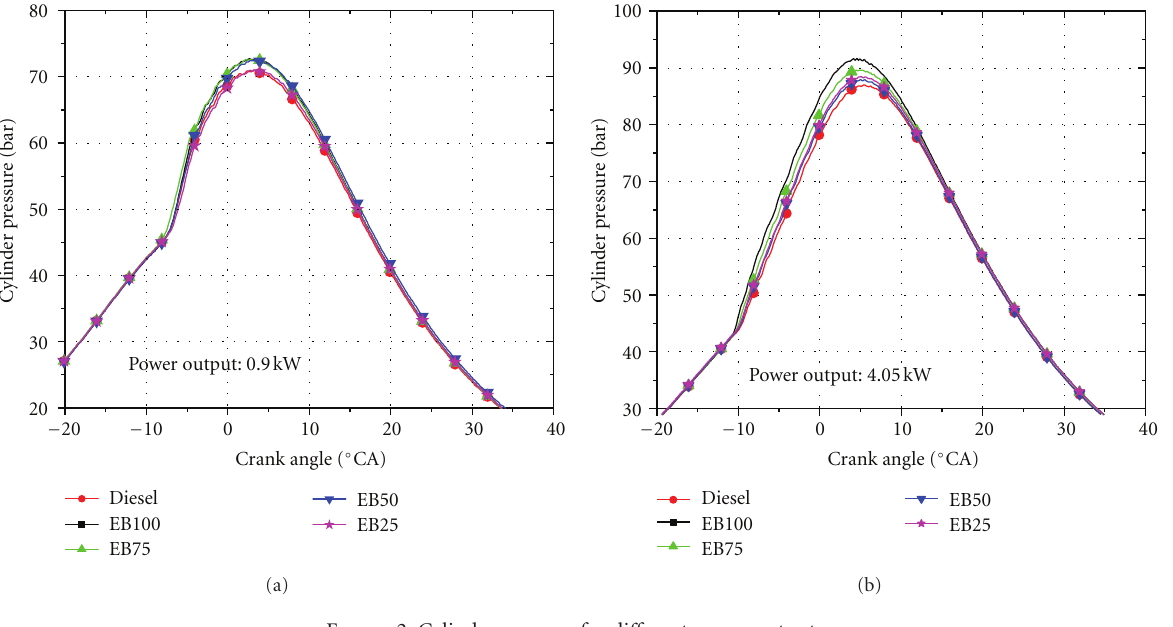
Figure 2: Cylinder pressure for di ff erent power outputs.